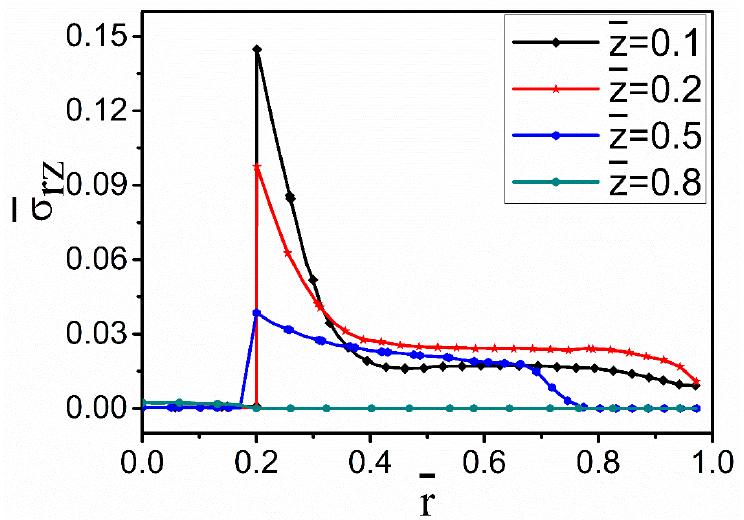
Figure 8. Variation in von Mises stress along the radial direction for the no-nickel-coating case at dimensionless time Fo =